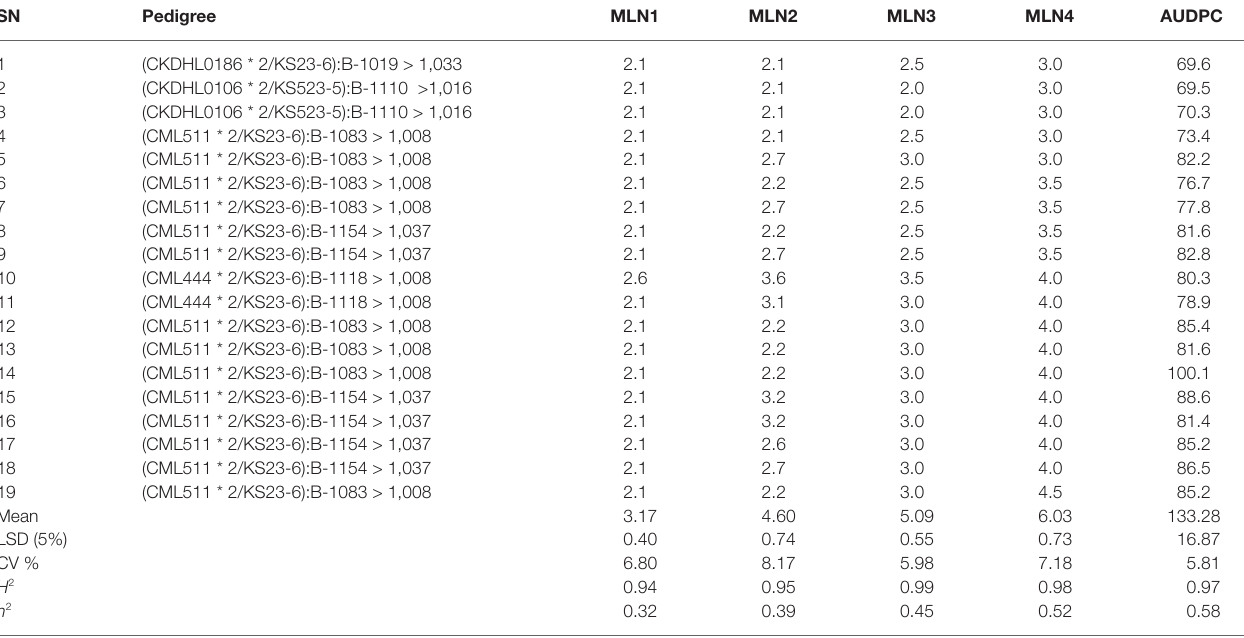
TABLE 8 | List of 19 MLN resistant BC 3 F 2 lines selected for testcross development. SN